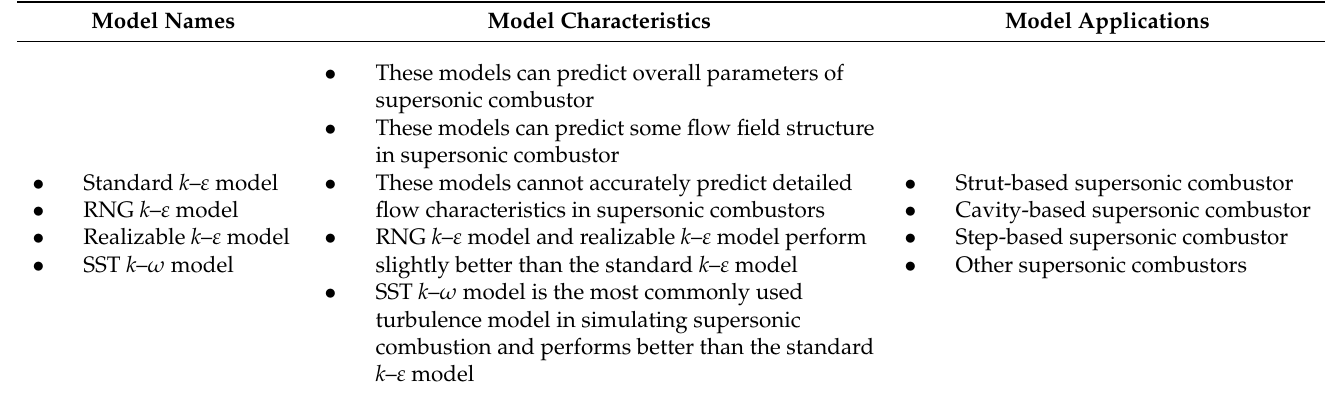
Table 2. Turbulence models commonly used for supersonic combustion on general